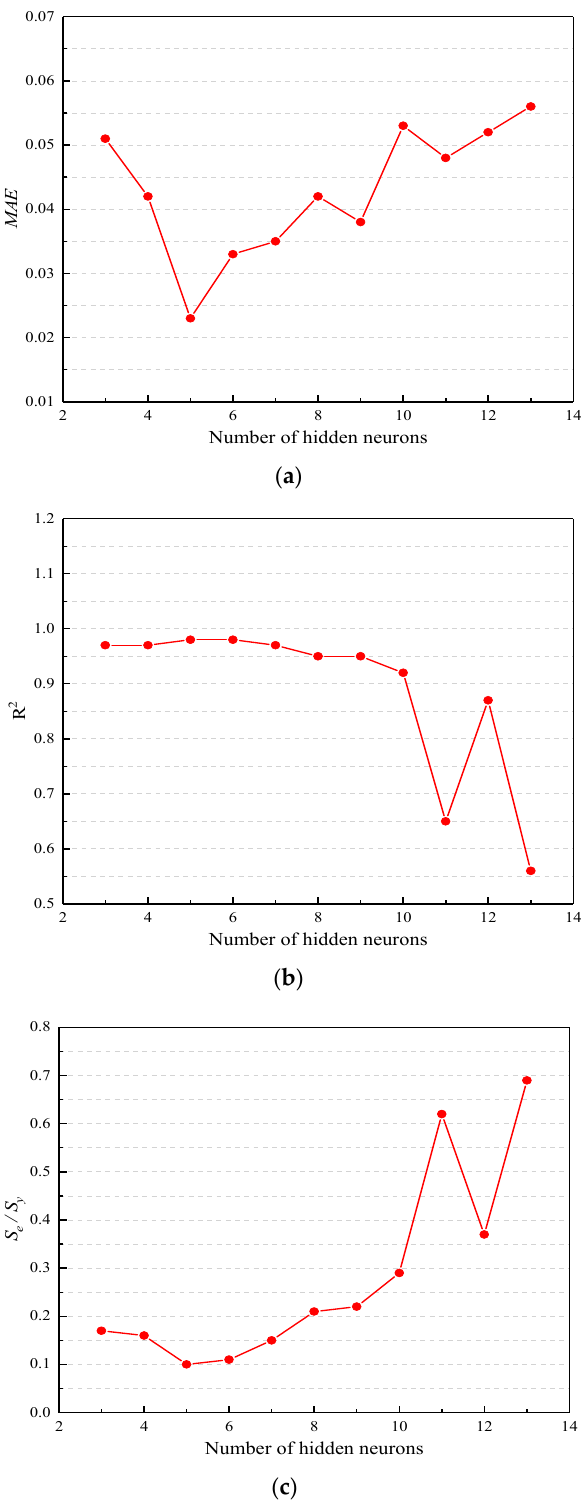
Figure 6. The results of the network structure with a different number of hidden layers: ( a ) The relationship between the mean absolute error (MAE) and the number of hidden neurons; ( b ) The relationship between R 2 and the number of hidden neurons; ( c ) The relationship between Se/Sy and the number of hidden neurons.